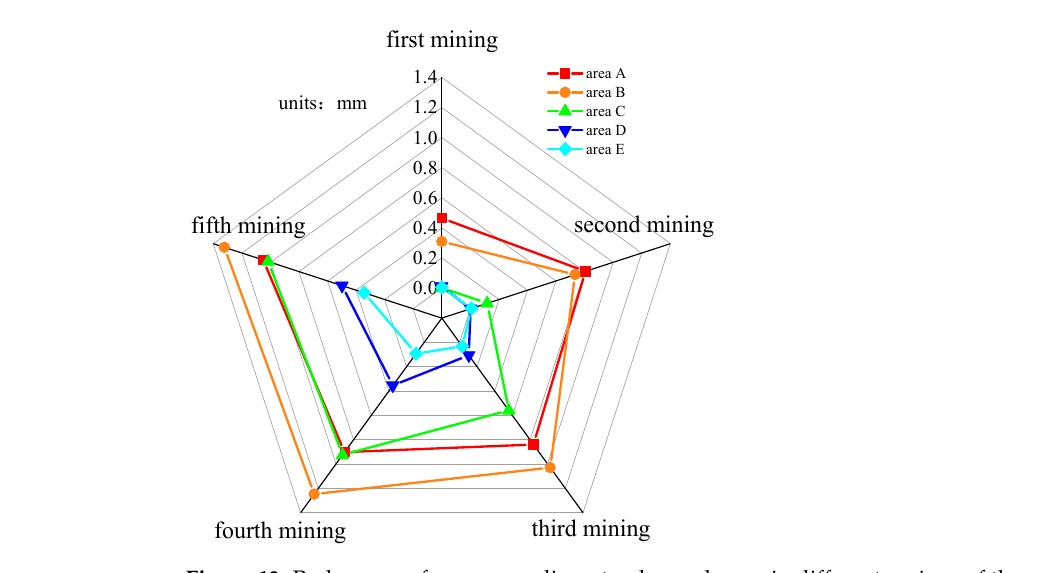
measuring line B